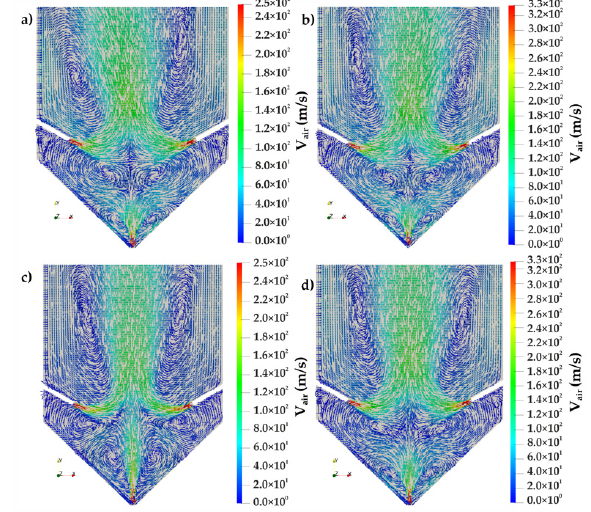
Figure 10. Time-averaged resultant vectors distribution of air velocity near the grinding region as a function of the solid holdup and the nozzle inlet pressure: ( a ) 400 g and 0.5 bar; ( b ) 400 g and 1 bar; ( c ) 700 g and 0.5 bar; ( d ) 700 g and 1 bar.